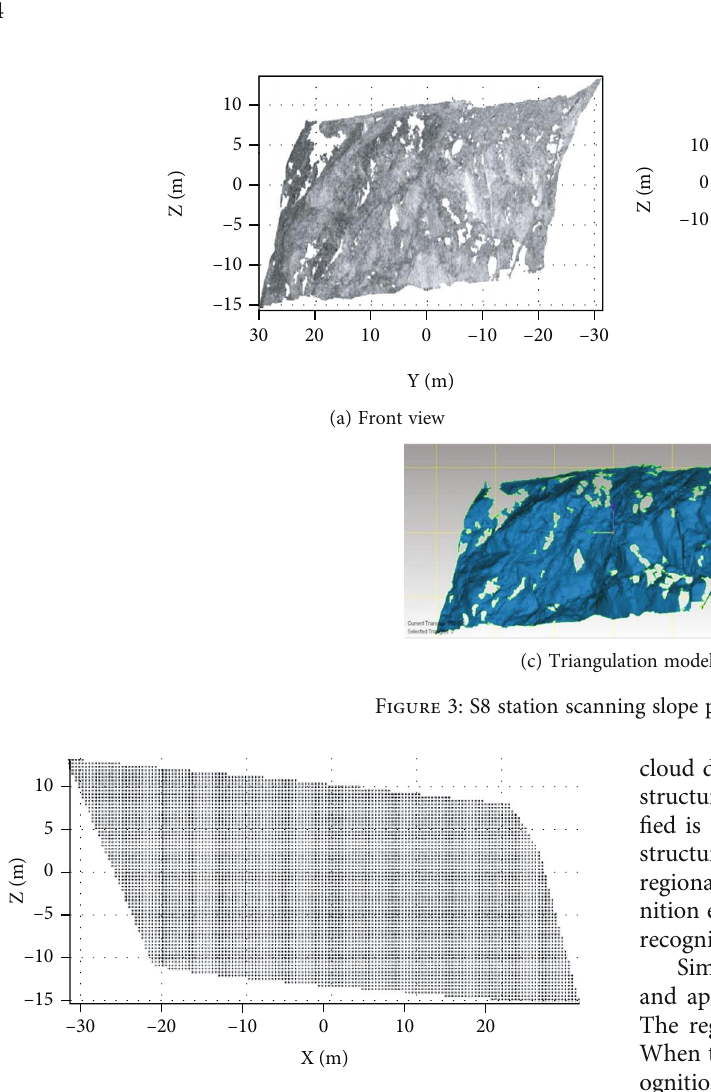
Figure 4: Result of grid